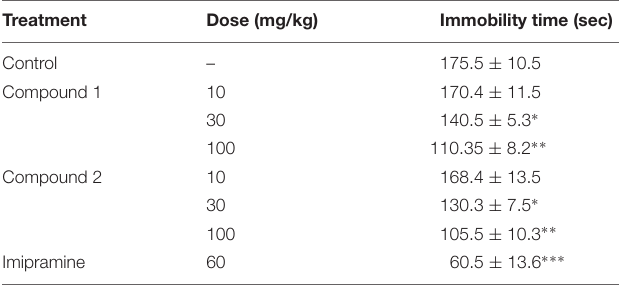
TABLE 2 | Effect of compounds on immobility time (sec) of mice using tail suspension test.